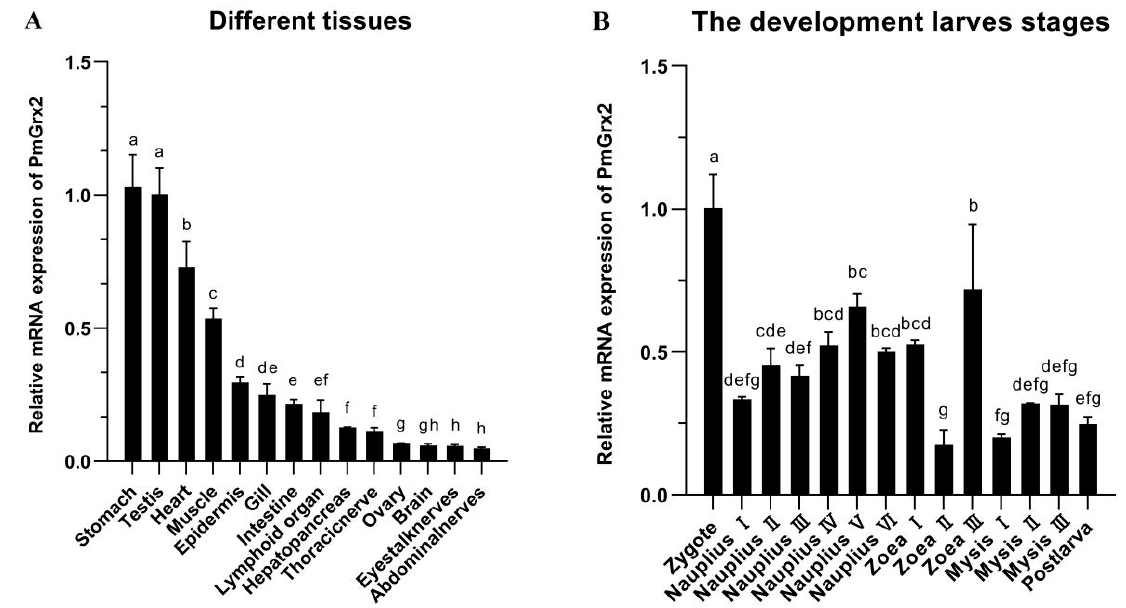
Figure 2. ( A ) mRNA expression levels of PmGrx2 in different tissues. The data are presented as mean ± SD (n = 3). Different letters show significant differences ( p < 0.05). ( B ) mRNA expression levels of PmGrx2 during the developmental period. The data are presented as mean ± SD (n = 3). Different letters are used to show significant differences ( p < 0.05).